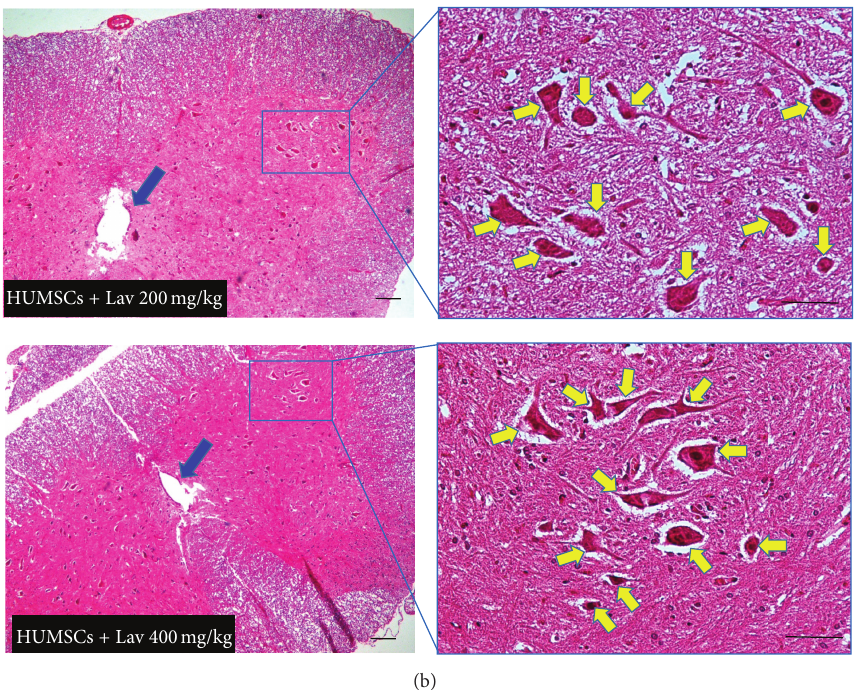
Figure 6: Stem cell therapy and administration of L. angustifolia improved histomorphological evaluation results in the rat spinal cord contusion model. Transverse section of spinal cord showing the ventral horn gray matter from spinal cord at the level of T12-L1 of all groups which evaluated in this study at day 56. H&E staining showed shrinkage and decrease of ventral horn motor neurons of HUMSCs in compare with control 1 (SCI) ( 𝑃 < 0.0001 ) and HUMSCs + Lav 100, 200, and 400 mg/Kg/day in comparison with HUMSCs. Yellow arrows illustrating the ventral horn motor neurons and blue arrows show central canal. HUMSCs therapy improved the number and shape of central canal and L. angustifolia extract potentiated this effect. Bar in 40X = 100 micrometer and bar in 200X = 50 micrometer. (ECLIPSE 5Oi